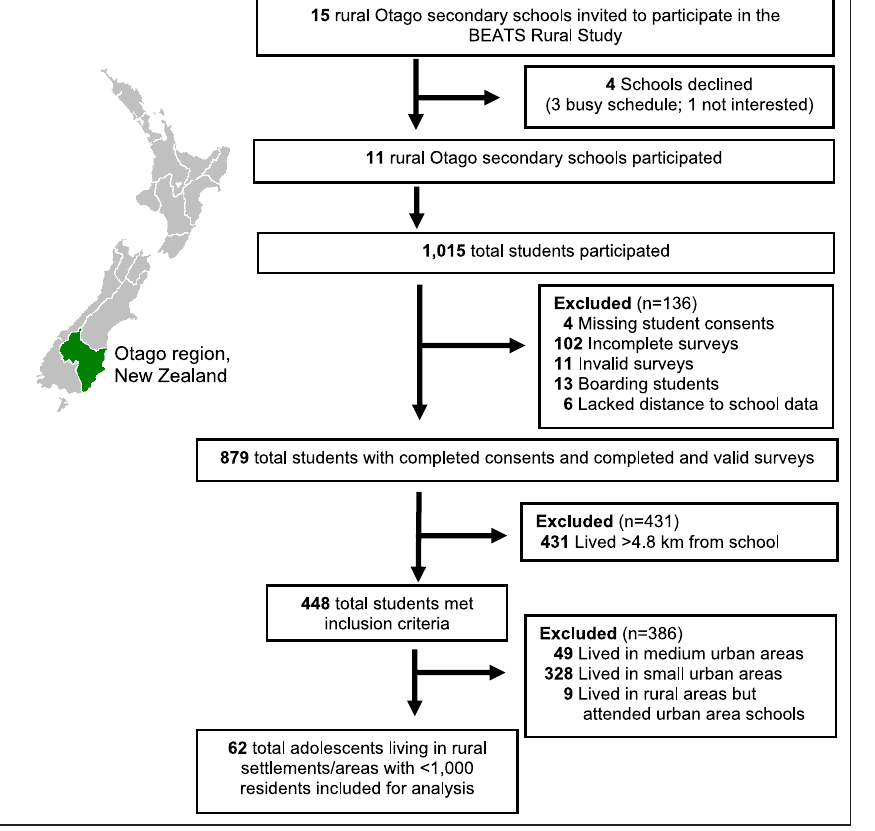
Figure 1: Flowchart of participant selection for data